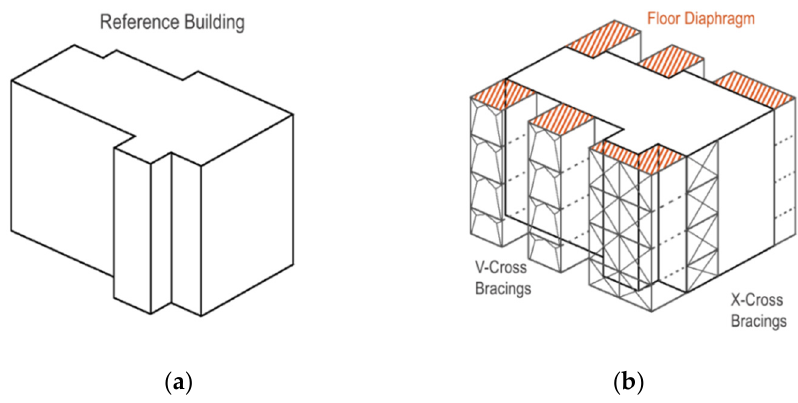
Figure 3. A schematic representation of ( a ) Reference building and ( b) Shear walls retrofit system.